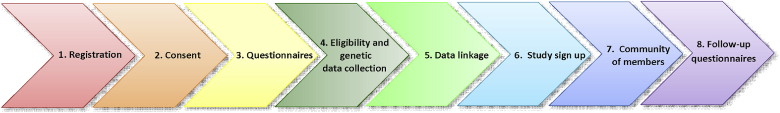
Stages of participant sign-up and involvement in the GLAD Study.